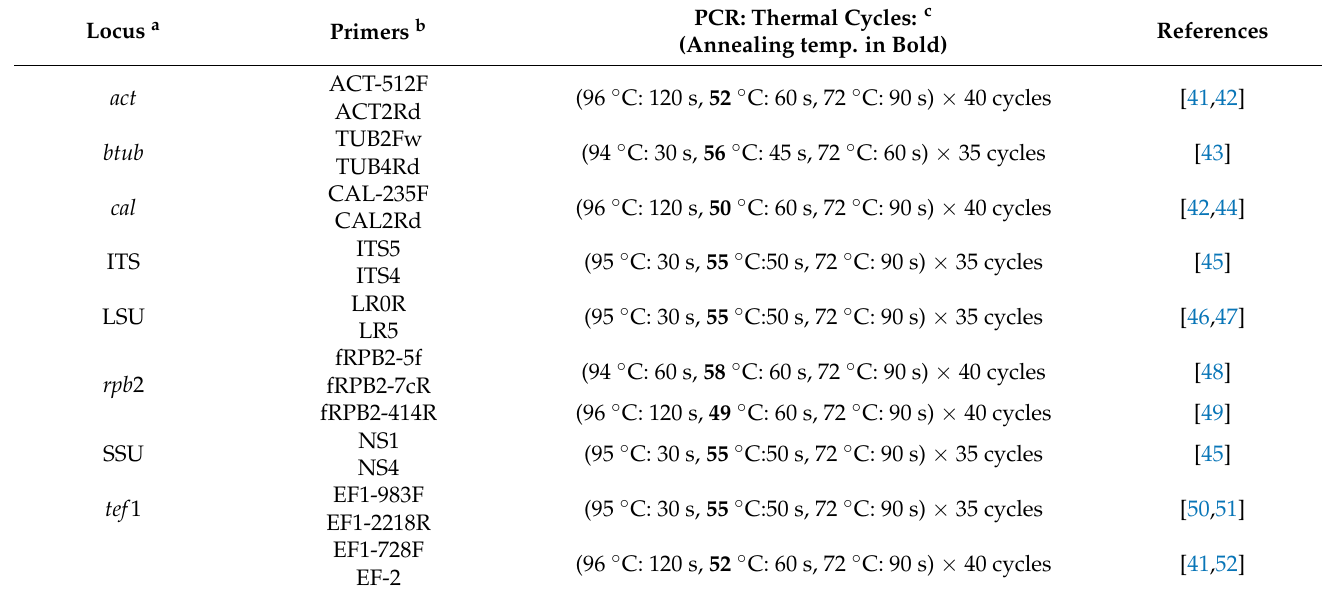
Table 1. Genes/loci used in the study with PCR primers, references and protocols. Locus a Primers b